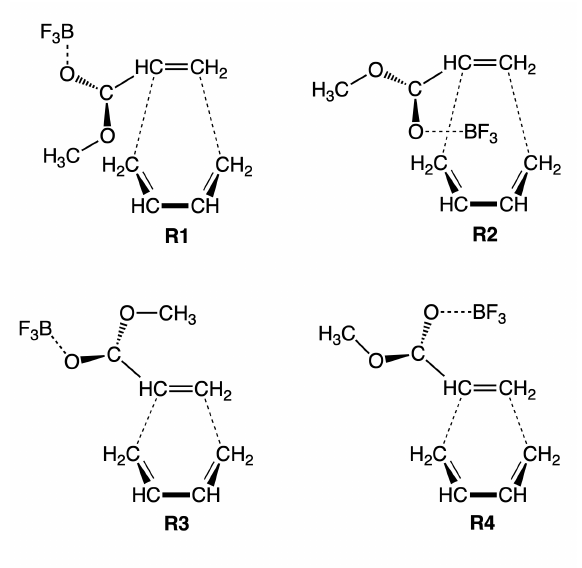
Figure 1. Schematic representation of the relative orientation of methyl acrylate and butadiene in the reactions R1 , R2 , R3 , and R4 catalyzed by BF 3 , which were investigated in our